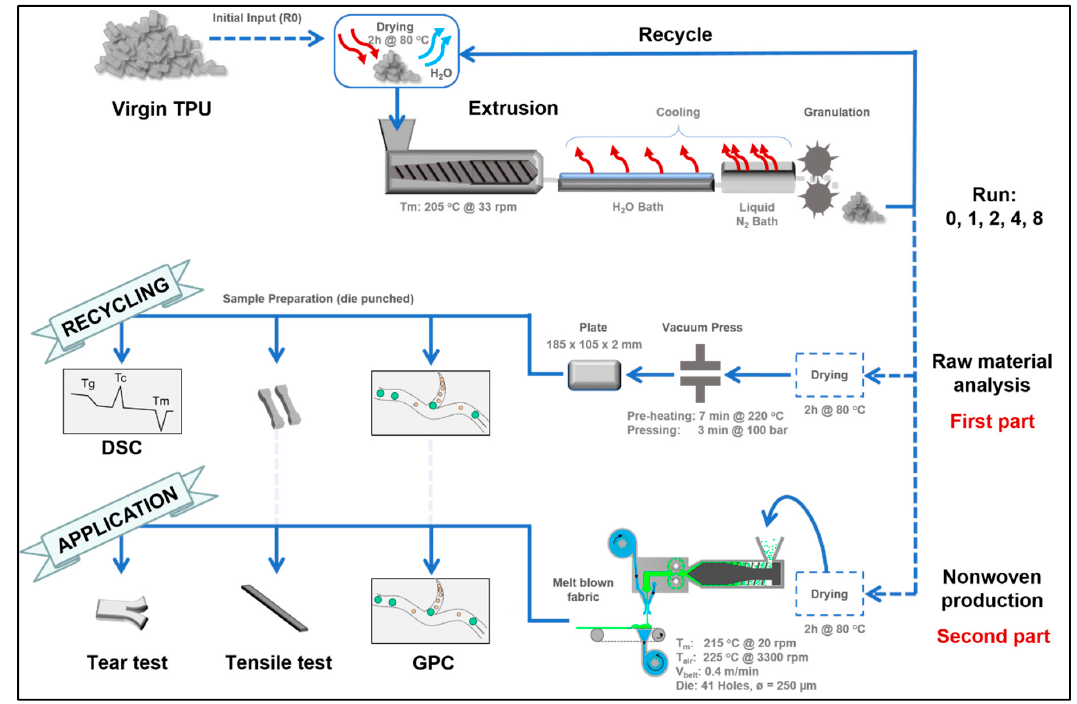
Figure 2. Schematic of the experimental setup: Reprocessing of the Thermoplastic Polyurethane (TPU) and characterization of the impact of recycling on the bulk material and application of the recycled materials as nonwoven through melt blowing. Relevant processing and sample preparation parameters are indicated.